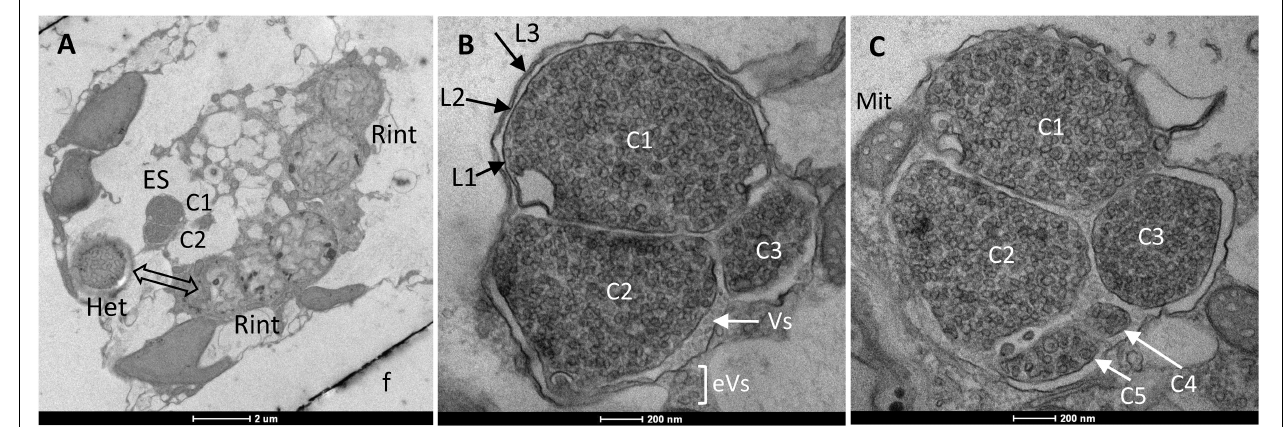
FIGURE 8 | Transmission electron micrographs of a third partner in H. hauckii . (A) Diatom cell showing R. intracellularis filaments (Rint), a heterocyst (Het) and an unidentified additional cytoplasmic partner (tentatively denoted endosymbiont, ES) with two cells (C1, C2); f, frustule. As observed in other sectioning planes, the heterocyst (Het) belongs to the filament indicated by a double arrow. (B,C) Magnified view of the second endosymbiont as observed in different sectioning planes. In panel (B) , the presence of three cells (C1–C3) and three possible envelope layers (L1–L3) are indicated. In panel (C) , the presence of five differently-sized cells (C1–C5) and of a mitochondrion adjacent to layer L3 are indicated. Note the presence of vesicles inside the cells, as well as in the periplasmic space (Vs in panel B ) and outside of L3 (eVs in panel B ).